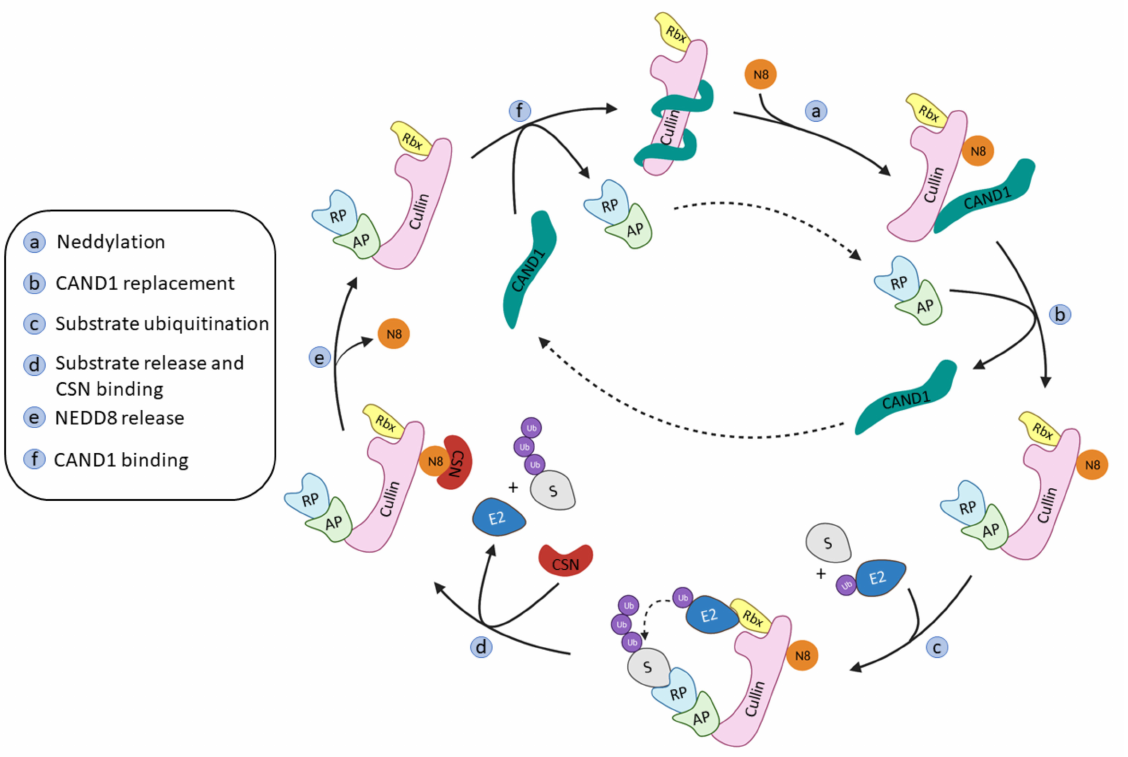
Figure 2. Schematic representation of the Cullin-RING ligases regulation and ubiquitination cycle adapted from Cui D. et al.